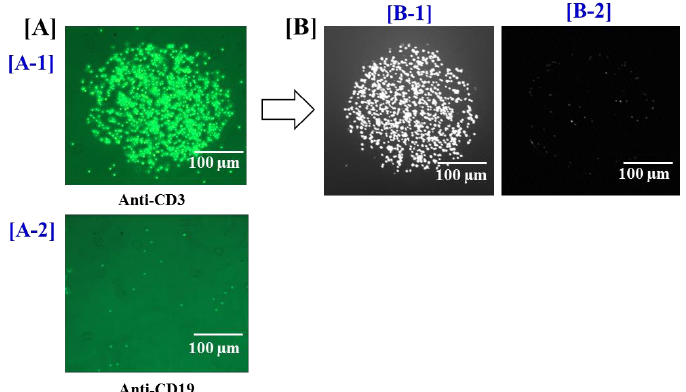
Figure 5. Specific capture of viable peripheral blood T lymphocytes on the